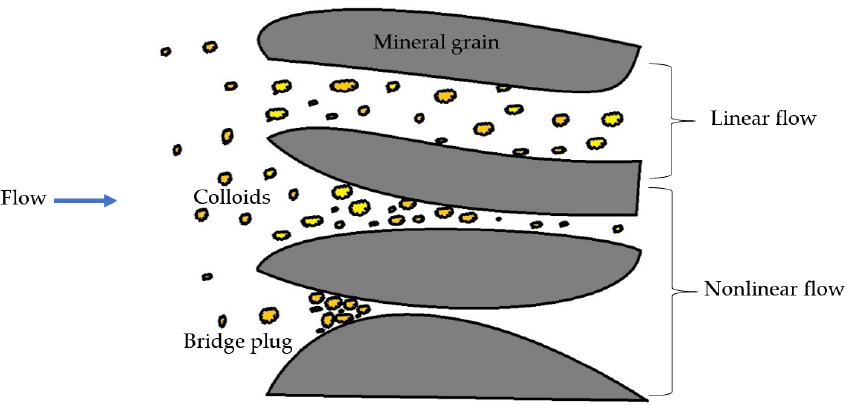
Figure 9. Scheme of pore channels blocking during the migration of colloids.